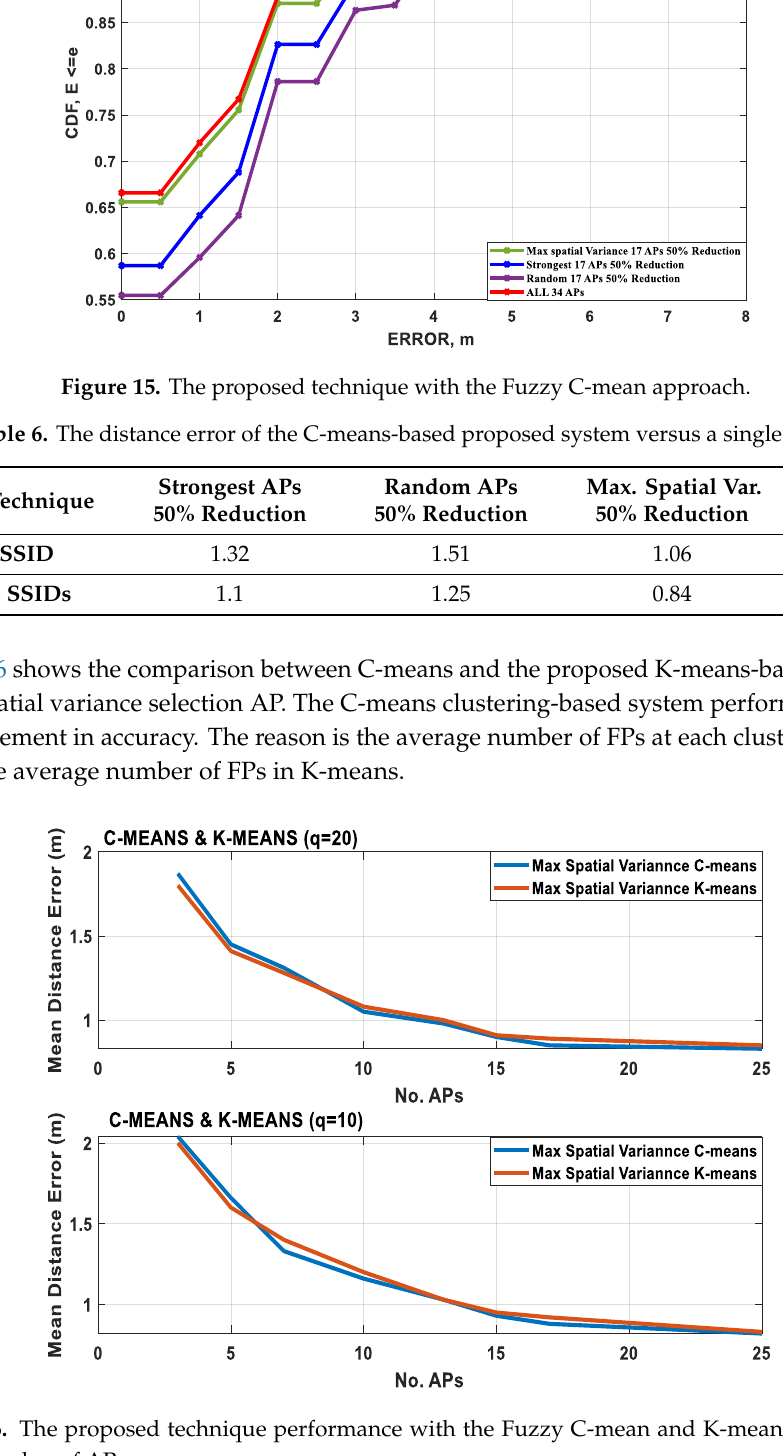
Figure 17. The proposed technique performance with the Fuzzy C-mean and K-mean approaches. 9. Conclusion and Future Work Indoor localization is an active and noble research area for its numerous applications in various areas of our daily lives. Within indoor environments, tracking people and localizing objects have become a necessity and thus motivates many researchers to tackle the challenges of IPS. In this article, the dimensionality reduction of MSSID’s RM has been proposed. Reducing the computational cost of IPS is very important for real-time system applications because large data require a long time to be processed. The reduction comprises three parts: first, clustering AOI into subareas to confine the